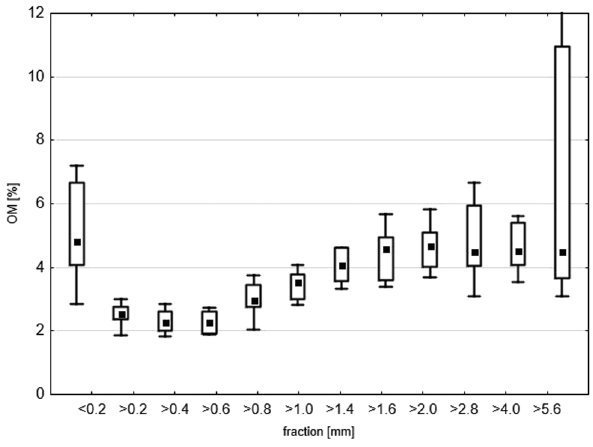
Figure 6: Box and whisker plots of OM ( % ) in LFW fractions. The edges of the boxes show SD, the whiskers show min – max, respectively. The mean is marked with a square